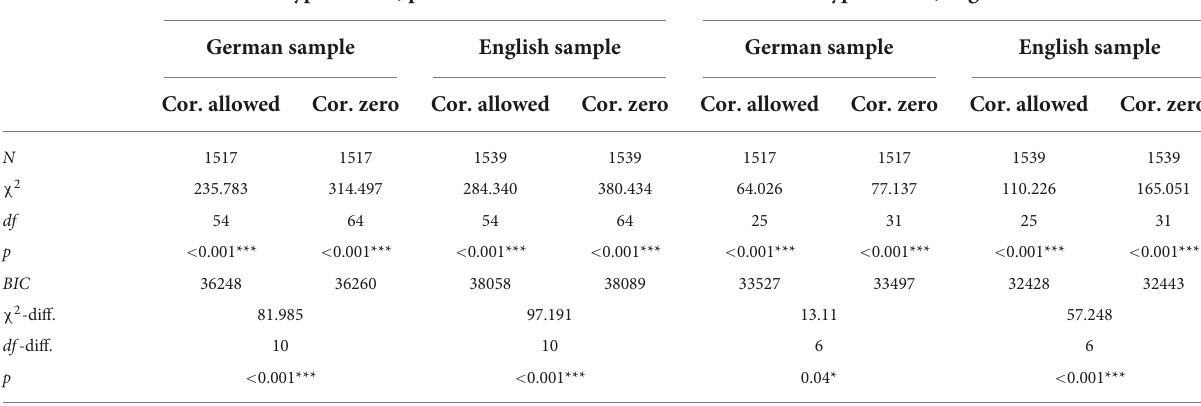
TABLE 5 Test statistics of all eight models and results of the four χ 2 -difference